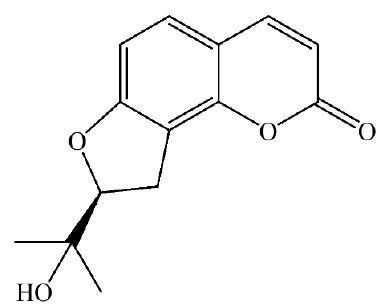
Figure 1. Chemical structure of (2 ′ S)-columbianetin.